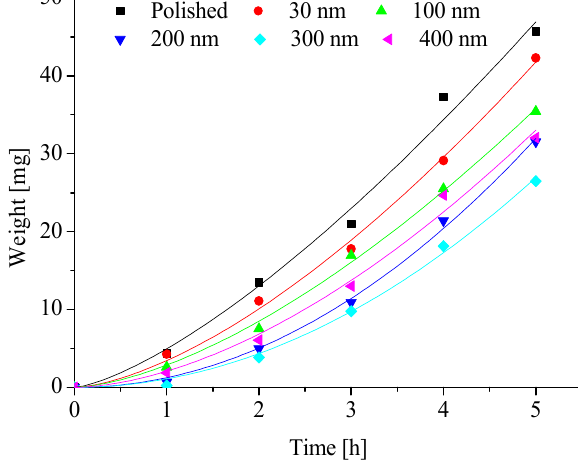
Figure 23. Testing value polynomial model regression fitting at T = − 10 °C, φ = 60%.